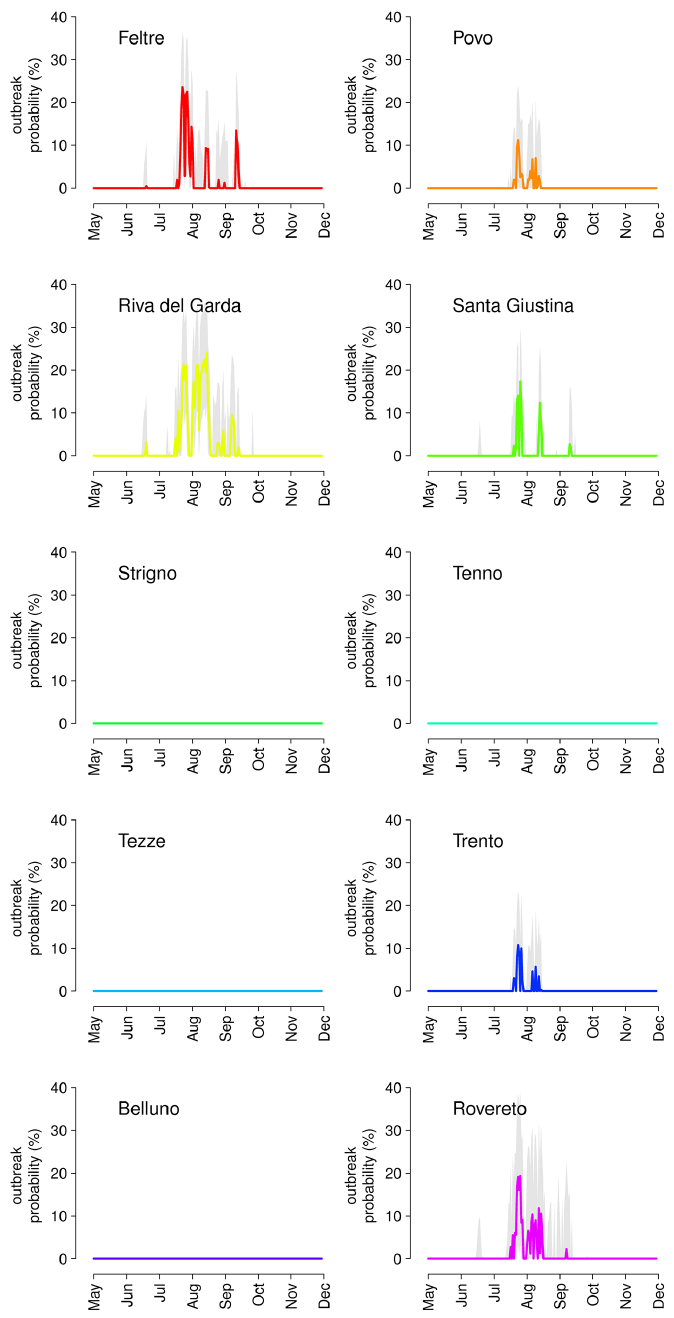
Fig 7. Model predictions for the probability of occurrence (average and 95% CI) of an outbreak of sustained dengue transmission caused by a single importation of an infected case occurred at different times of the year in the ten study